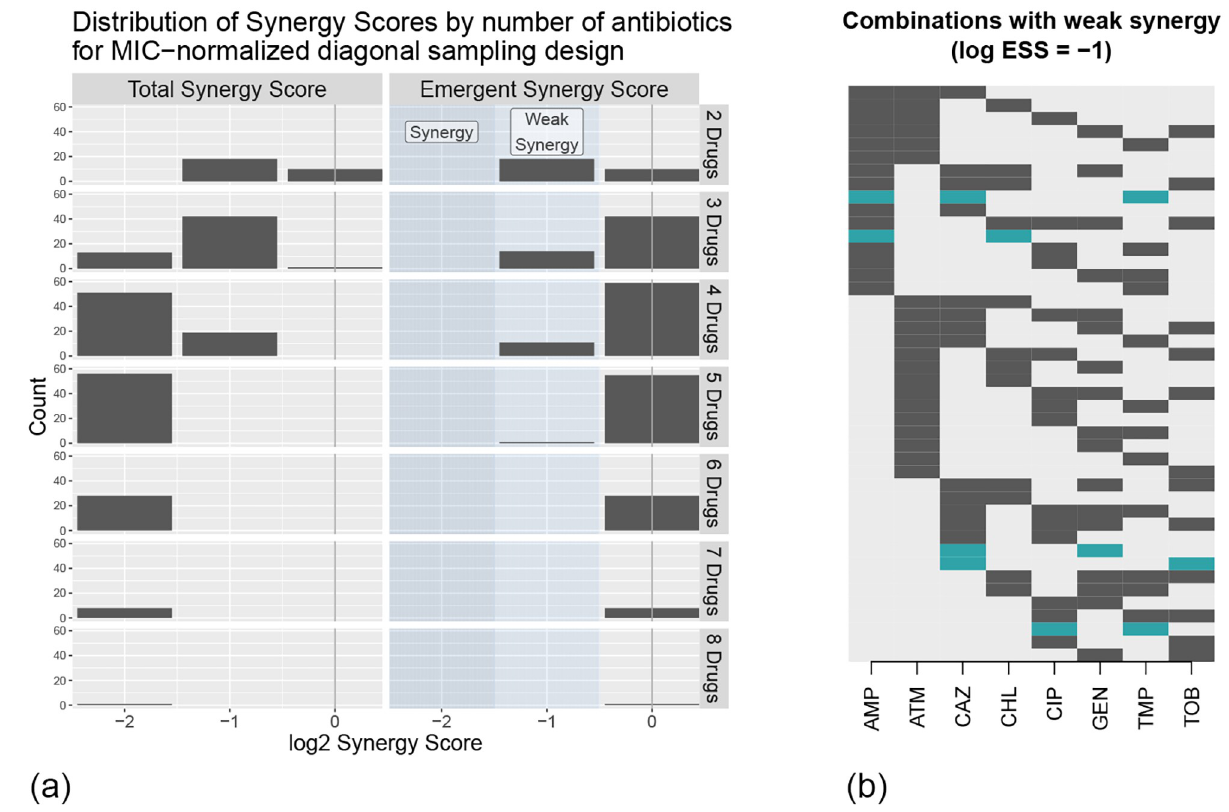
Fig 3. Results of the MIC-normalized experiment. (a) Distribution of TSS and ESS scores across all 2 8 different MIC-normalized combinations of the eight antibiotics in Table 1, separated by the number of drugs in the combination. (b) Representations of the 44 drug combinations exhibiting weak synergy; combinations that were also weakly synergistic under the breakpoint normalization are shown in blue. Each row represents one combination; black/blue indicates presence of the drug, while gray indicates absence.